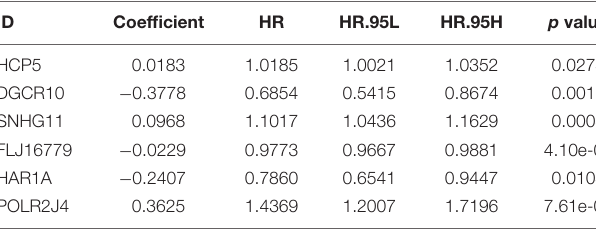
TABLE 1 | The expression levels of these six